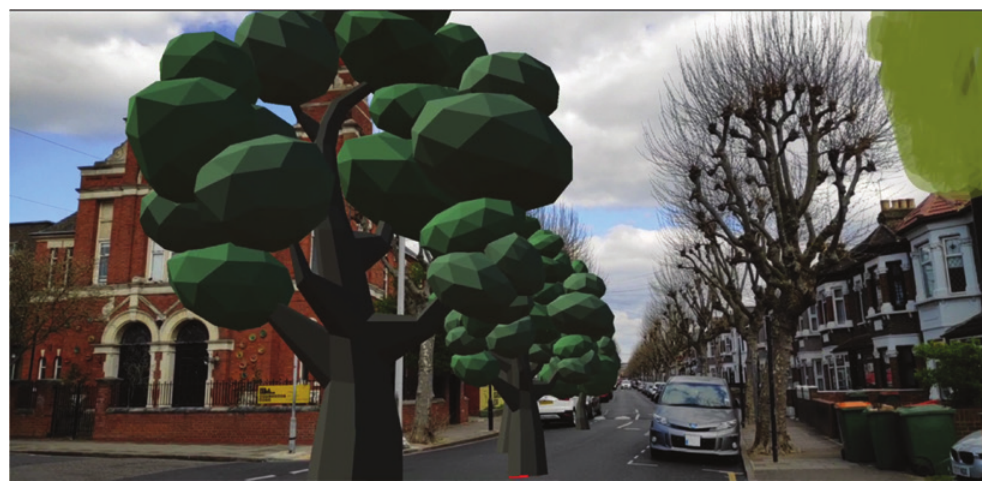
figure 6: 3D objects placed in augmented reality (screenshot: luca